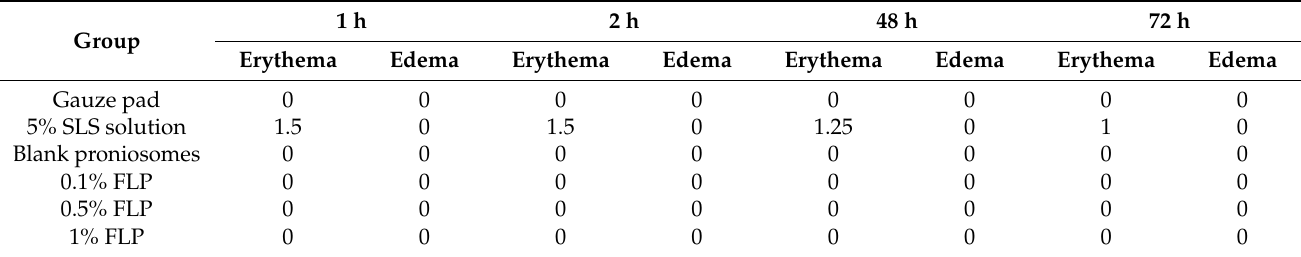
Table 7. Skin irritation scores. FLP, Finasteride loaded-proniosomes.